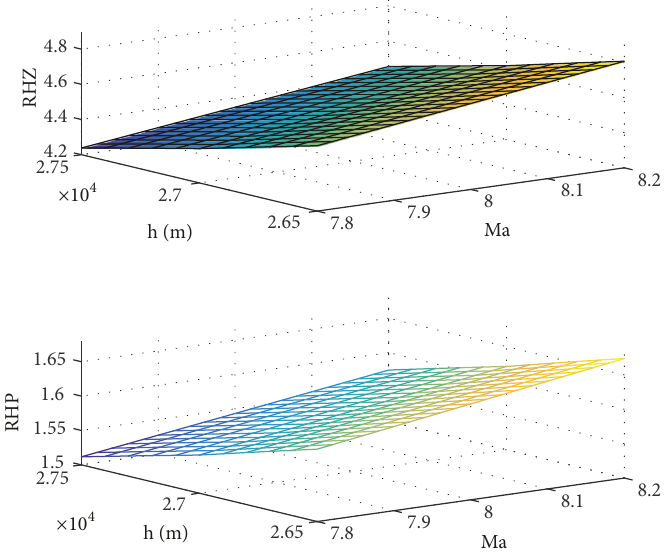
Figure 5: Change surfaces of zero and pole on the right plane with regard to 𝑀𝑎 = 7.8 − 8.2 and ℎ = 26.5𝑘𝑚 − 27.5𝑘𝑚